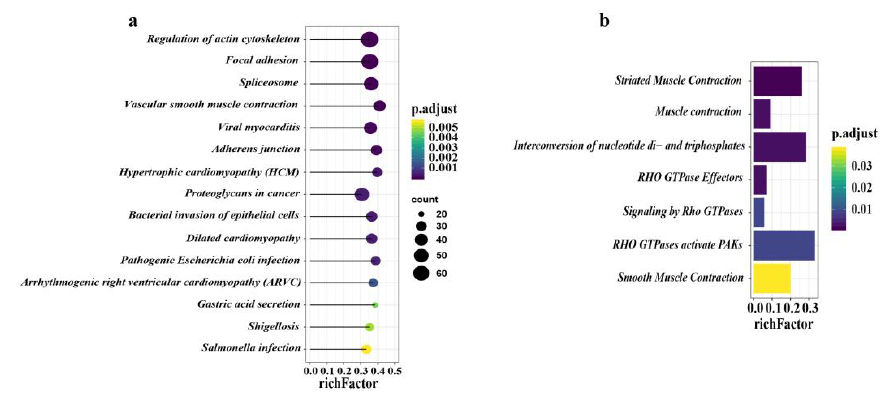
Figure 5. KEGG (Kyoto Encyclopedia of Genes and Genomes) and Reactome pathway annotation analysis. ( a ) The top 15 pathways of all DEPs in KEGG enrichment analysis. ( b ) All seven pathways of DEPs in Reactome pathway analysis. The X-axis indicates the rich factor, and the Y-axis indicates the pathway. Bar colors represent p -values.